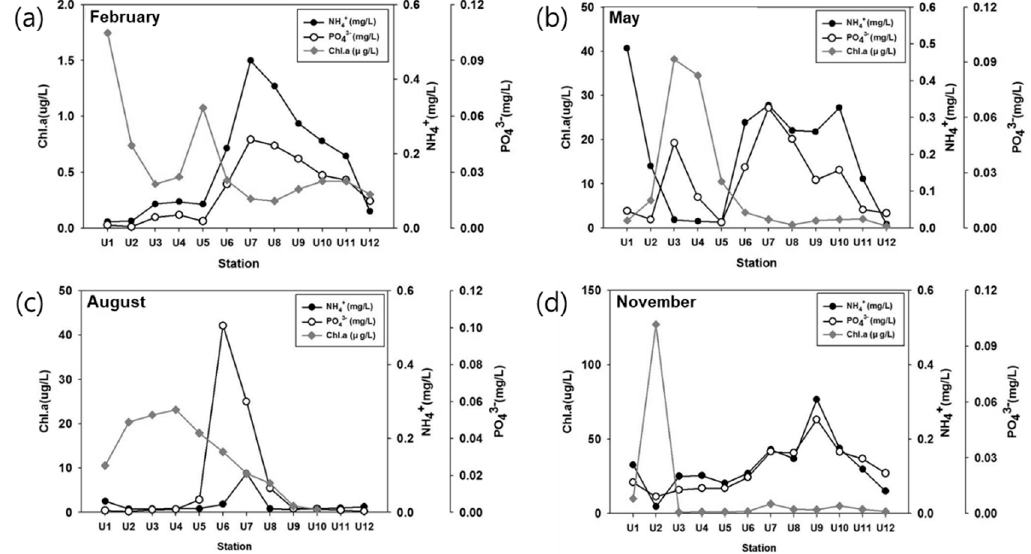
Figure 11. Chl.a and nutrients (ammonium, phosphate) at stations in the Taehwa River estuary in Korea. ( a ) February, ( b ) May, ( c ) August, and ( d ) November.